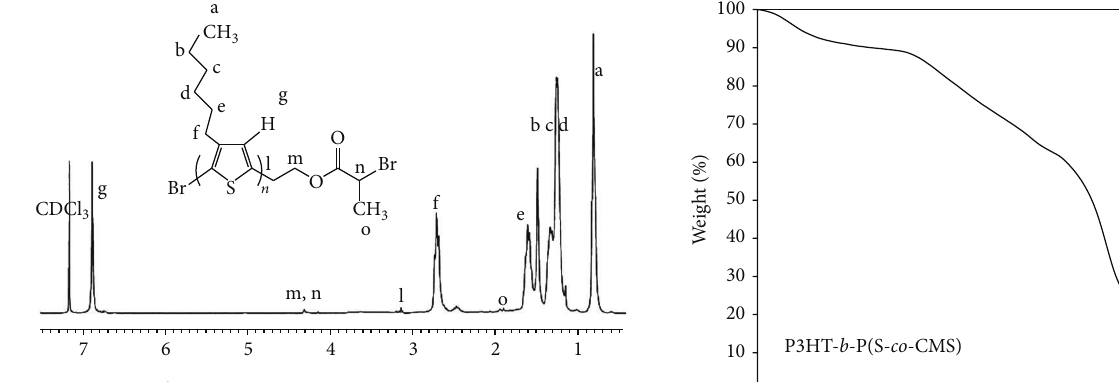
Figure 4: 1 H-NMR spectrum of the P3HT macroinitiator.